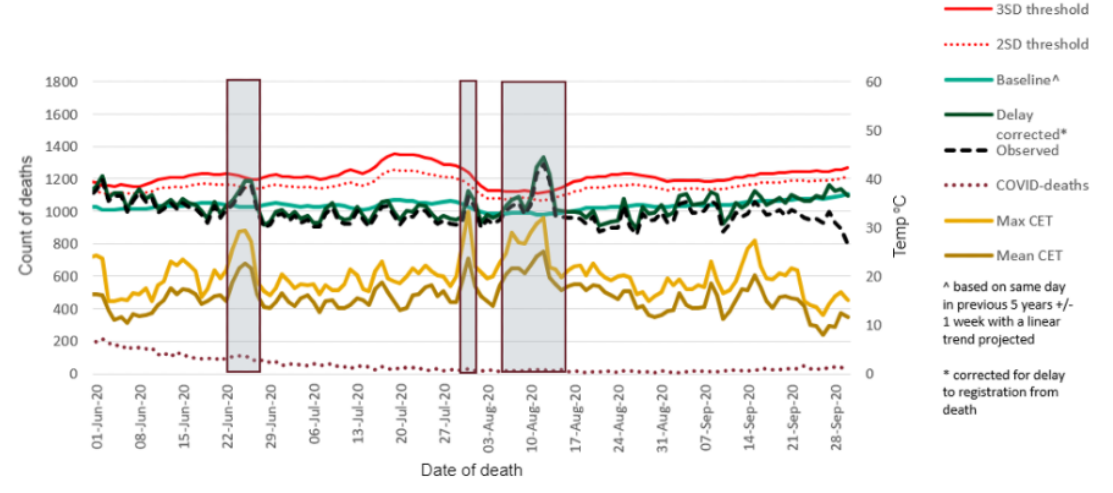
Figure 1. All-cause excess mortality in 65+ years group during the 2020 summer period. The shaded areas highlight periods which meet the Heatwave Plan for England (PHE) heatwave criteria for estimating heatwave excess mortality [23].